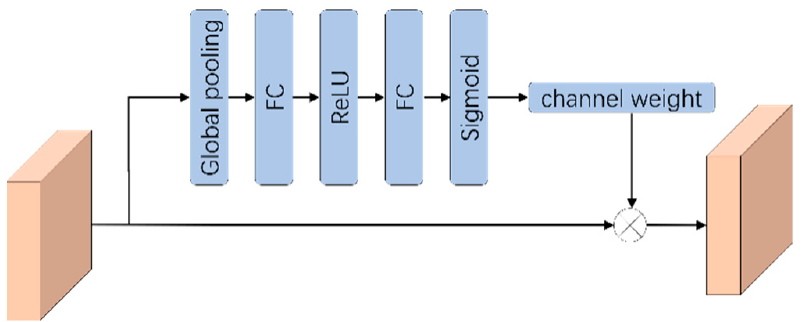
Figure 2. Attention mechanism.